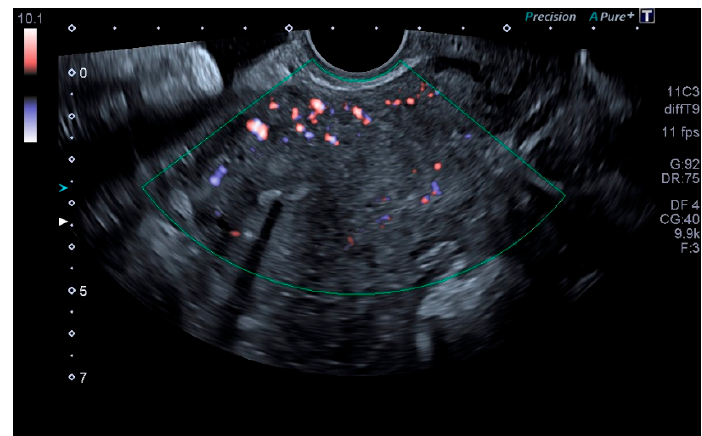
Figure 1. Crossing veins in the myometrium.